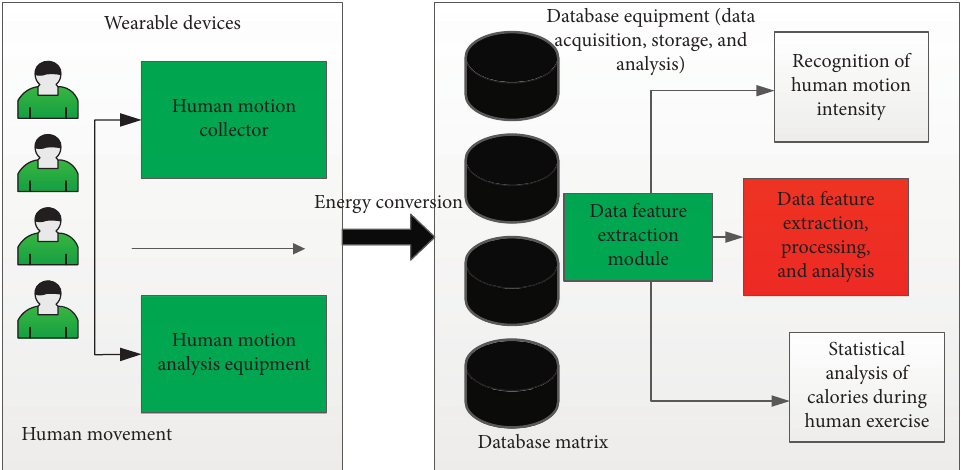
Figure 2: Framework of athlete’s energy consumption estimation.